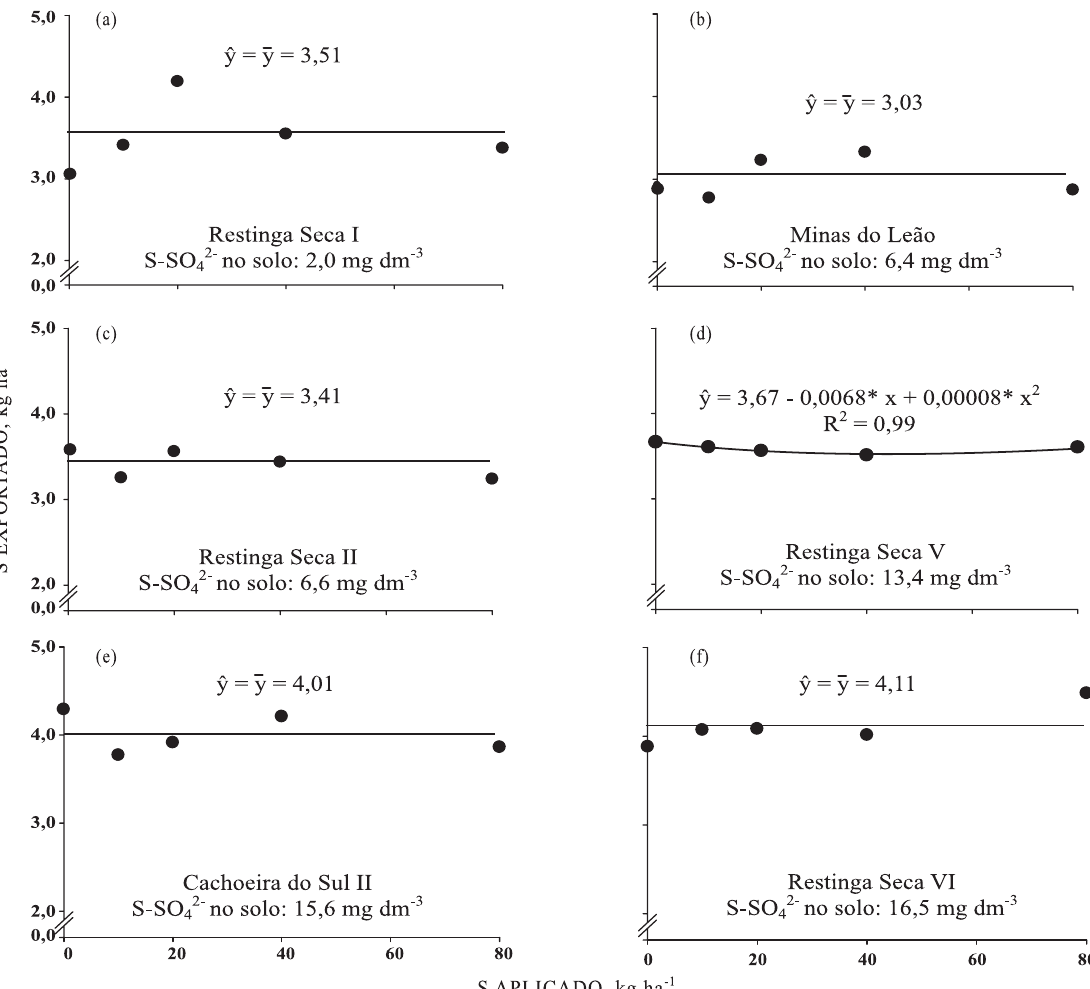
2. Enxofre exportado pelo arroz irrigado, em função da aplicação de doses deste elemento em diferentes locais, na safra 2005/2006. *Significativo pelo teste F (p <